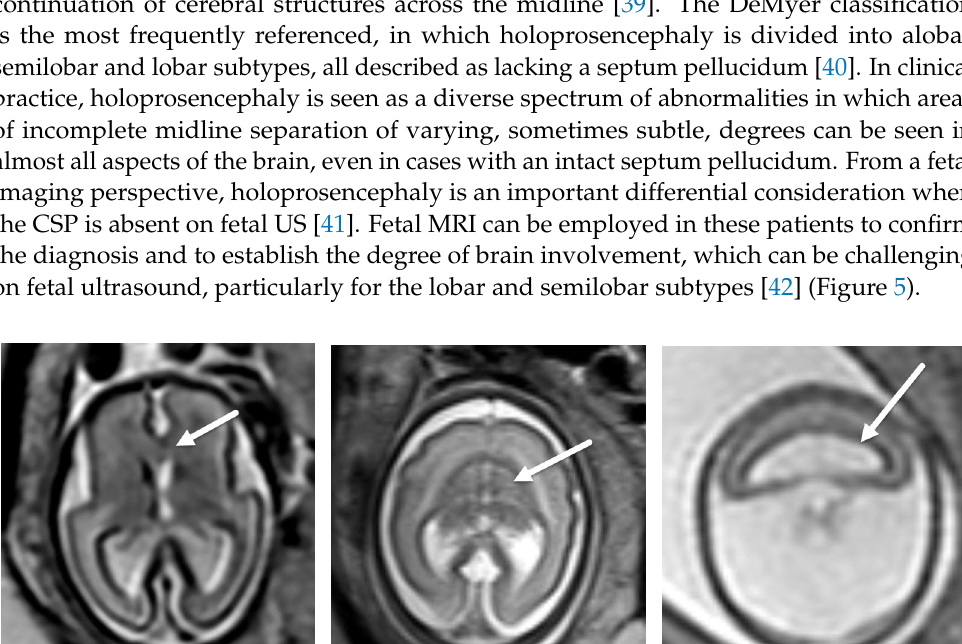
( b ) ( c ) Figure 6. Agenesis of the corpus callosum in the Sakoda complex. Axial image of fetal ultrasound at 24 weeks GA ( a ) for cleft lip and palate (not shown) demonstrates absence of the CSP and colpo- cephaly (arrows) suspicious for agenesis of the corpus callosum. This is confirmed on subsequent fetal MRI at 24 weeks and 1 day GA. Coronal T2-SSFSE image of the brain ( b ) demonstrates up- turned frontal horns of the lateral ventricles (arrows) and absence of the corpus callosum connecting